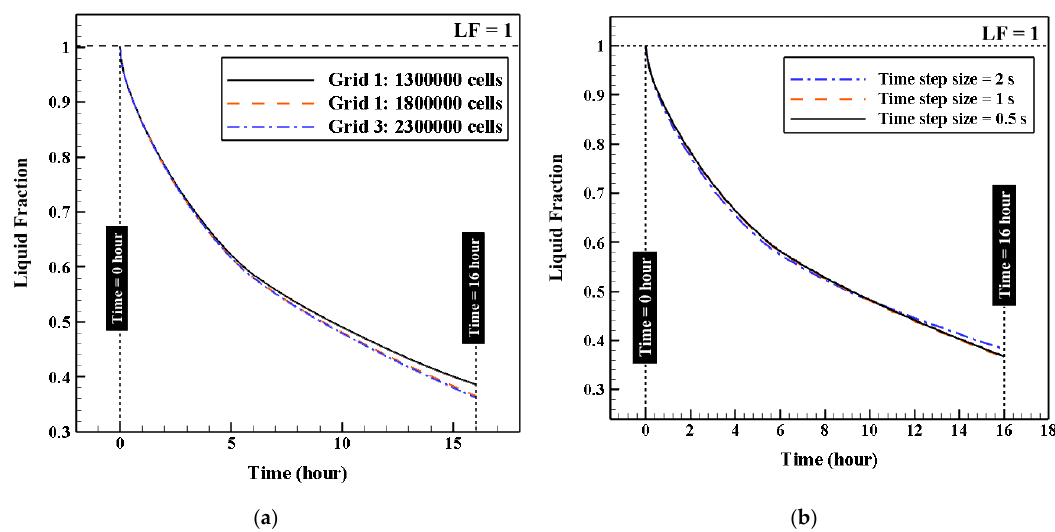
Figure 5. Grid ( a ) and Time-step ( b ) independence tests.